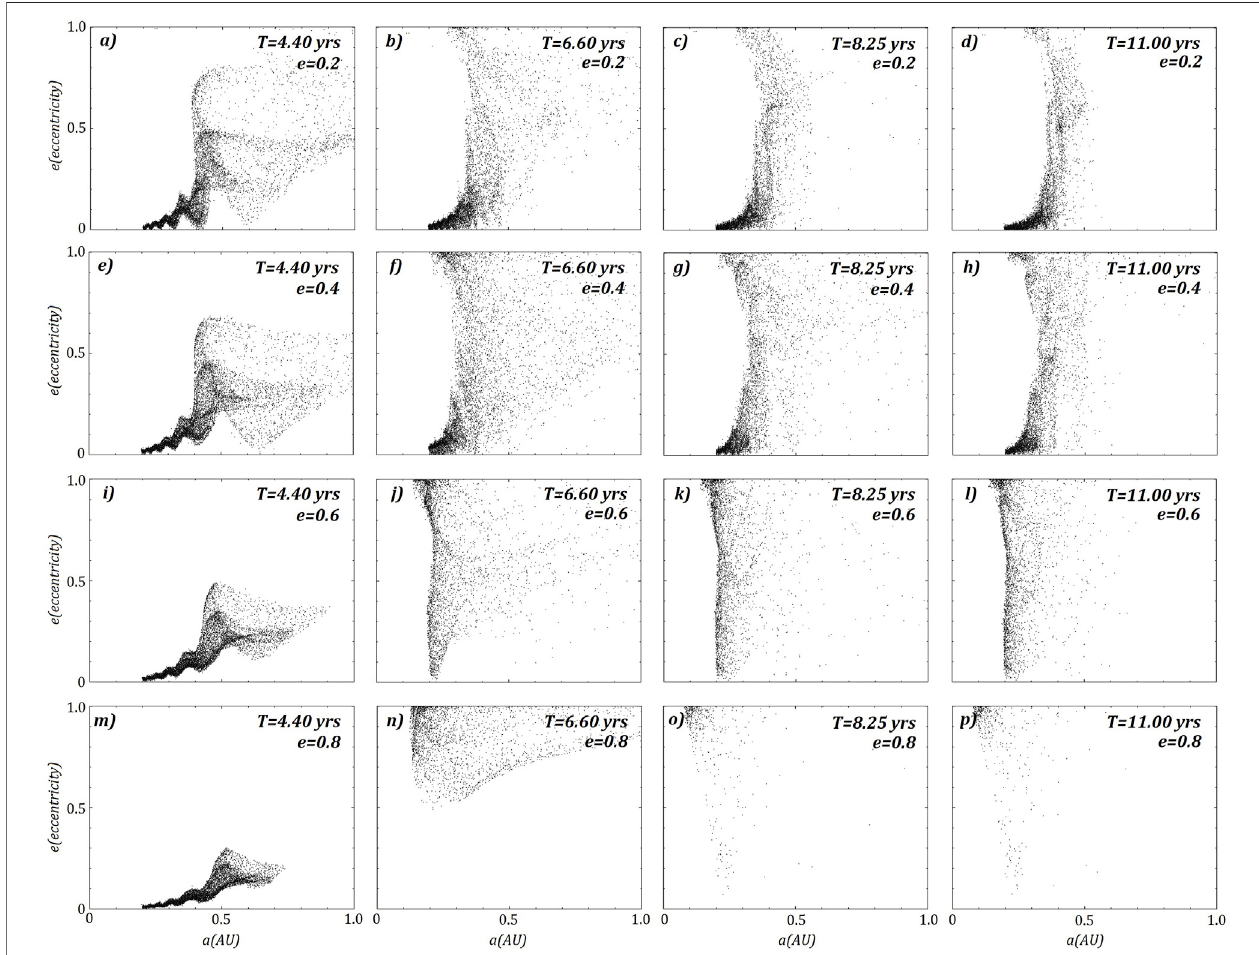
FIGURE 10 | The same four prograde ring models shown in Figure 1 . Here the calculated eccentricities and semi-major axis for all ring particles are plotted. The rows represent each model, where e (cid:1) 0 . 2 (A – D) , e (cid:1) 0 . 4 (E – H) , e (cid:1) 0 . 6 (I – L) and e (cid:1) 0 . 8 (M – P) , while the column represents a snapshot in time at T (cid:1) 4 . 40 yrs ( A , E , I & M ) , T (cid:1) 6 . 60 yrs ( B , F , J & N ) , T (cid:1) 8 . 25 yrs ( C , G , K & O ) , T (cid:1) 11 . 00 yrs ( D , H , L & P ) , where all models began at